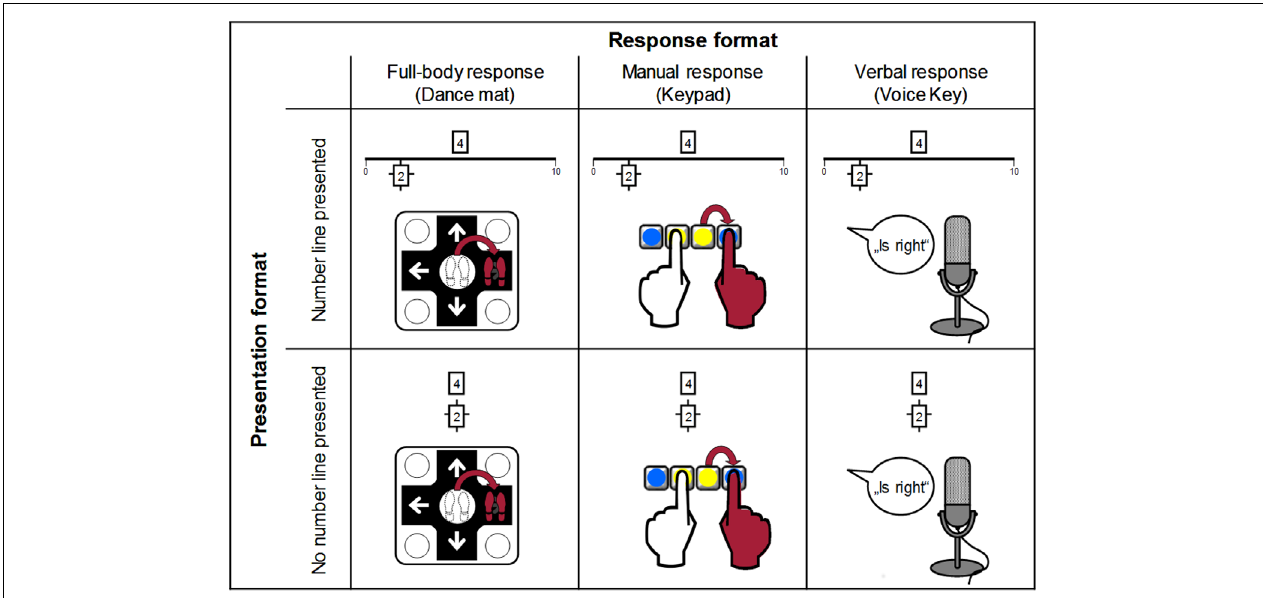
FIGURE 1 | Variation of response and visual presentation formats demonstrated on the magnitude classification of 4 vs. 2. Here, the number 2 is marked as the standard for comparison, so participants had to decide whether 4 is larger or smaller than 2.